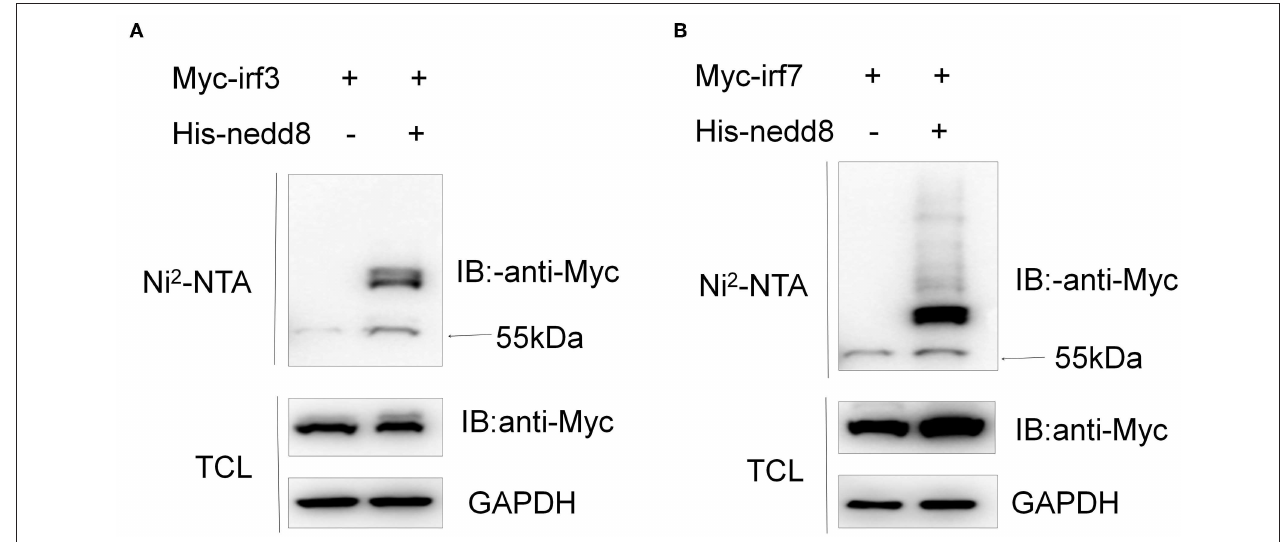
FIGURE 10 | Neddylation of zebrafish Irf3 and Irf7 exists. HEK293T cells were transfected with Myc- irf3 (5 µ g) (A) or Myc- irf7 (5 µ g) (B) together with His- nedd8 (5 µ g). After 36h, cells were lysed in guanidinium chloride, and His- nedd8 was purified with Ni 2 -NTA agarose. TCL, total cell lysates; IP,